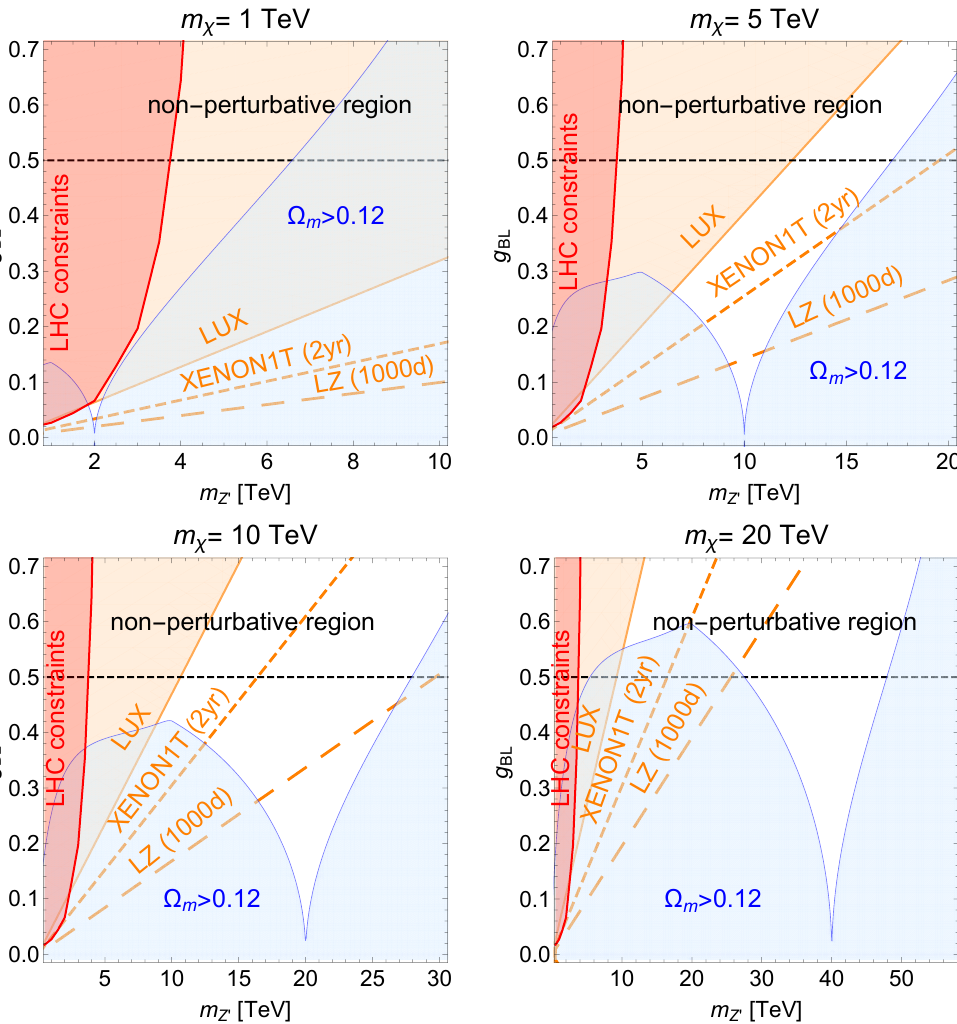
Figure 2 . Summary plots of our results. The red region to the left is excluded by LHC con- straints on the Z 0 (see text for details), the region above g BL > 0 : 5 is non-perturbative due to p 2 (cid:25) . In the blue shaded region DM is overabundant. The orange coloured region is g BL q max (cid:1) (cid:20) already excluded by direct detection constraints from LUX [72], the short-dashed line indicates the future constraints from XENON1T [74] (projected sensitivity assuming 2 t the future constraints from LZ [75] (projected sensitivity for 1000d of data